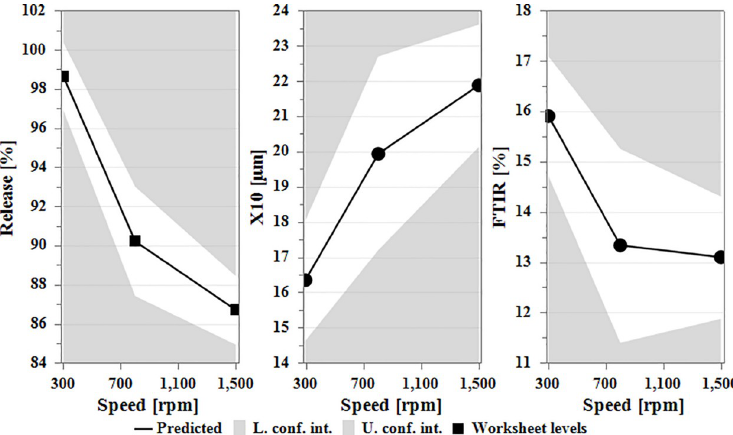
Fig 8. Main effect plot of batch size on the dissolution, PSA and FTIR spectrum when other factors maintained at their middle values. Note the D-optimal design has no centre points and hence were not displayed.